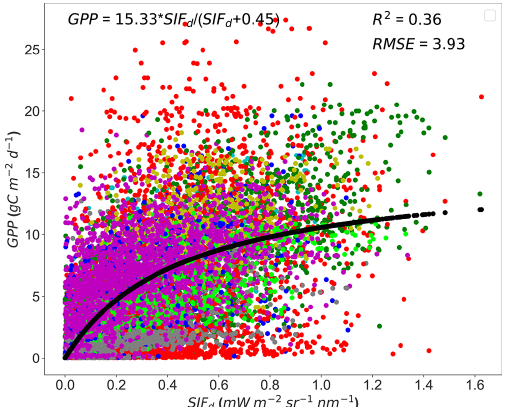
Figure 4. Scatterplots of the relationships between tower-based GPP and SIF d in eight PFTs pooled together across all sites. The dotted black line represents the hyperbolic fit between the GPP and SIF d . The color code represents the plant functional types encoun- tered in the study sites: red stands for croplands (CROs), green for deciduous broadleaf forests (DBFs), yellow for evergreen broadleaf forests (EBFs), magenta for evergreen needleleaf forests (ENFs), blue for grasslands (GRAs), cyan for mixed forests (MFs), lime for open shrubland (OSH), and dim-grey for wetland